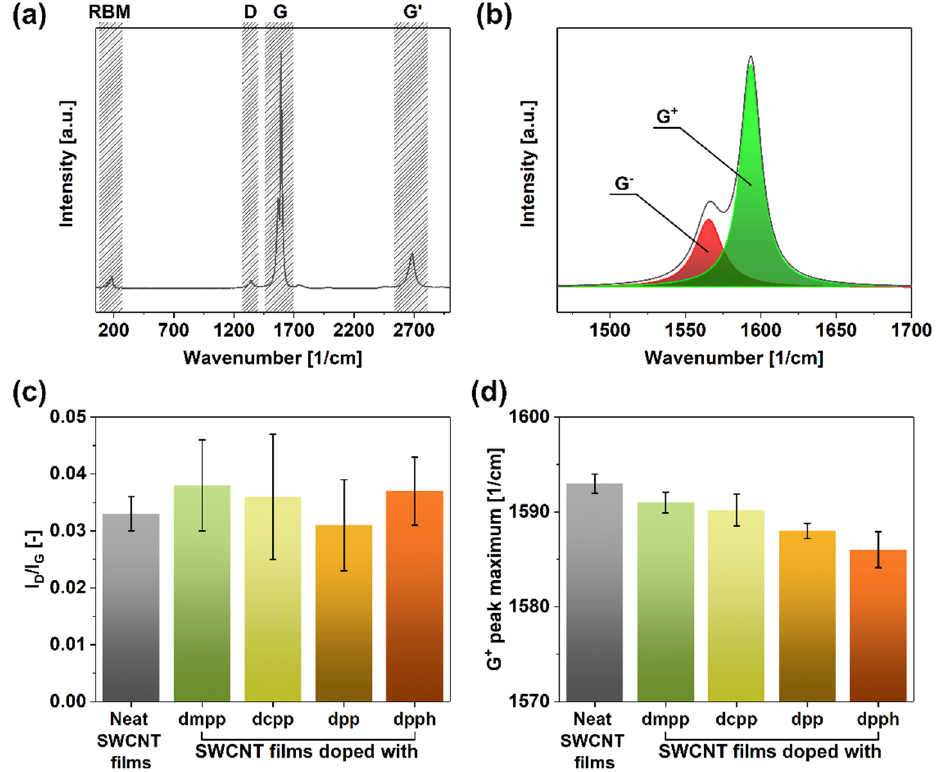
Figure 2. ( a ) Full Raman spectrum of a neat SWCNT film, ( b ) magnification of the G peak area with exemplary deconvolution into G − and G+ components, ( c ) I D /I G ratios of SWCNT films before and after doping, and ( d ) corresponding recorded positions of G+ peak maxima after deconvolution.